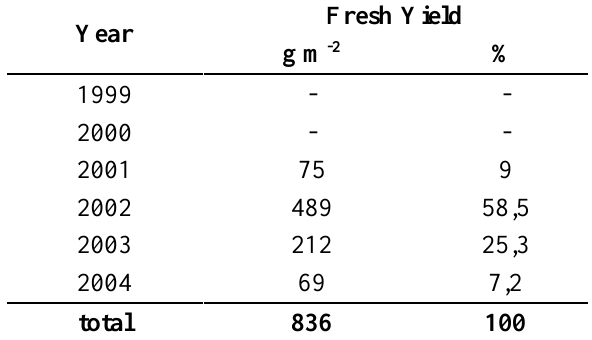
Table 4. Fresh yields of Drosera rotundifolia in peat beds (total 54 m 2 ) between 1999 and 2004 in Mikkeli, Finland. Source: Galambosi & Galambosi (2013).